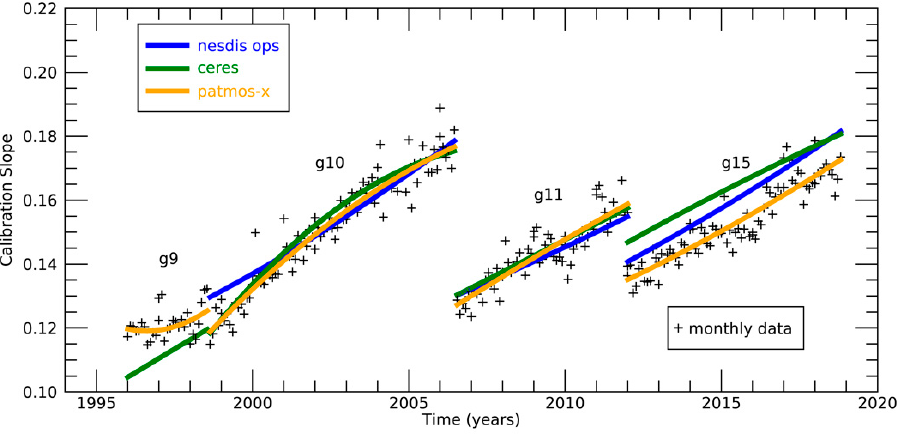
Figure 6. Same as Figure 5 for GOES-West. Table 4. Calibration slope coefficients and metrics of the fitting performance.